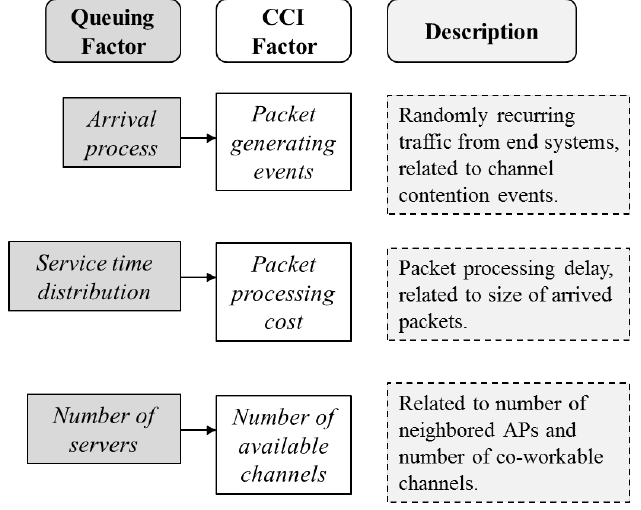
Figure 3. Relationship between queuing model and CCI